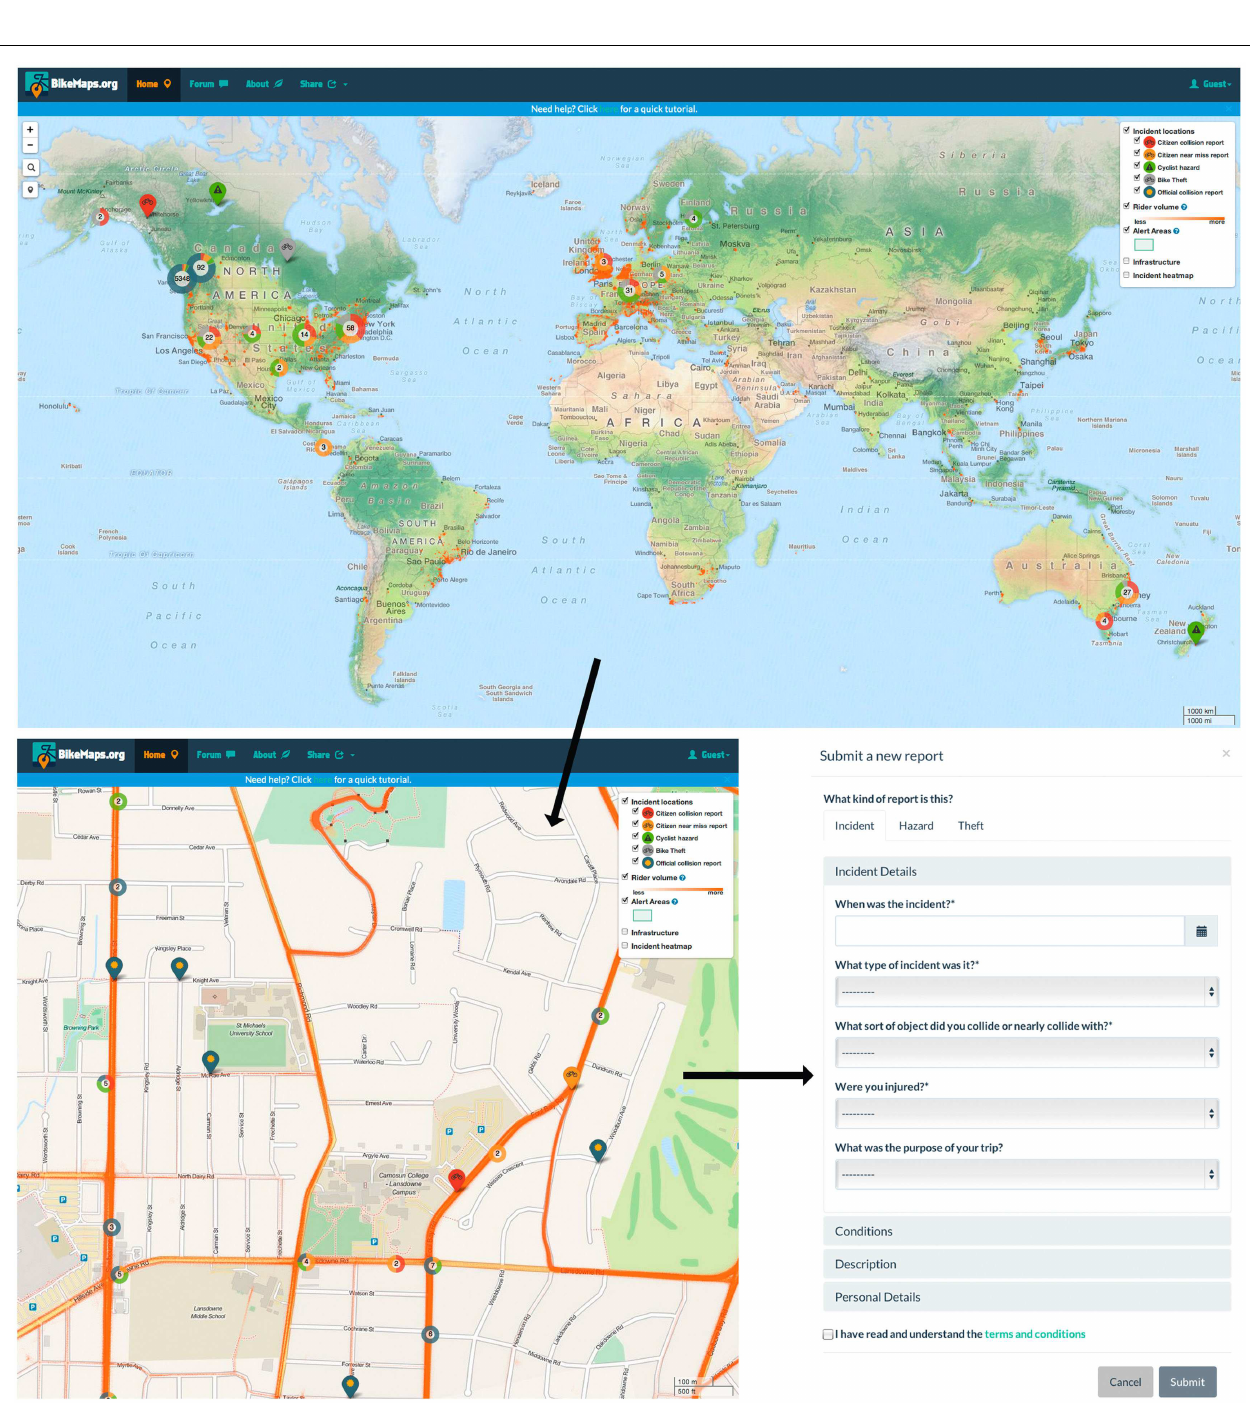
FIGURE 1 | BikeMaps.org is a global tool for citizen mapping of cycling collisions, near misses, hazards, and thefts .The upper panel shows the website and global map.The lower panel – left is a close up of the map and